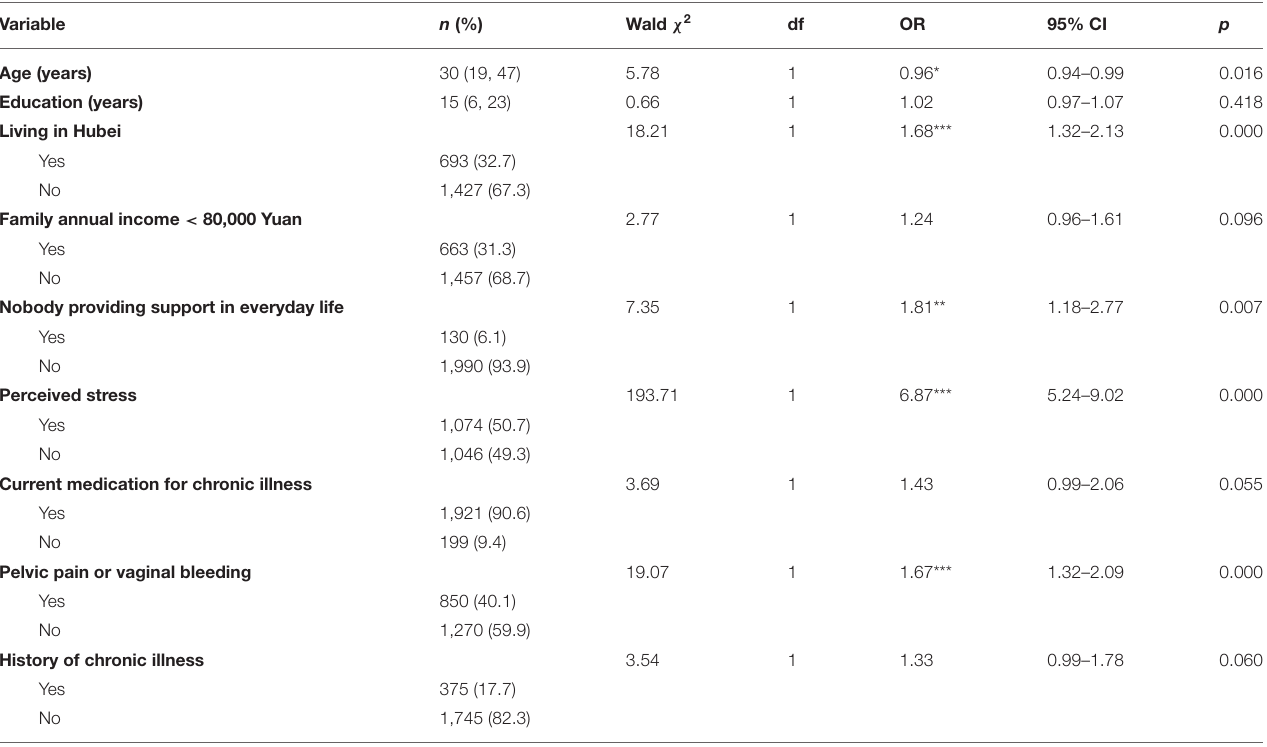
TABLE 2 | Factors associated with prenatal anxiety.